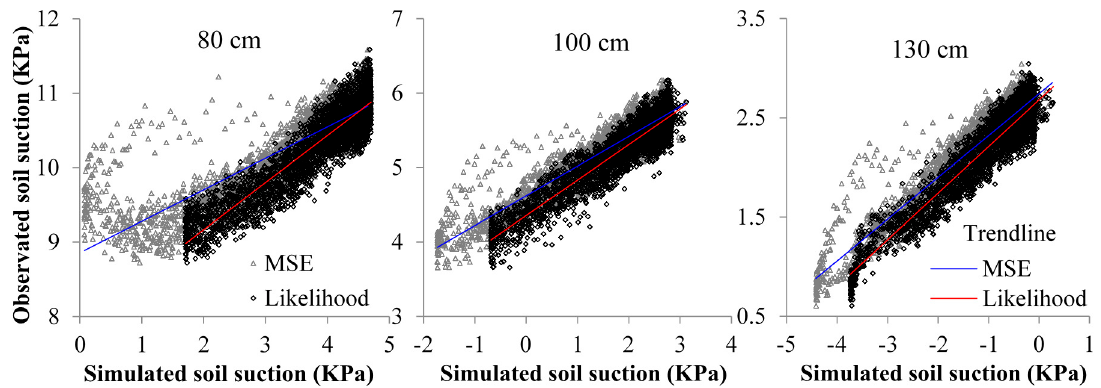
Figure 6. The observation soil suctions versus the simulations at the depths of 80, 100, and 130 cm in the first rainfall–runoff experiment. Note that the positive value of soil suction means that soil is unsaturated, rather than saturated, which is opposite to the value of the water pressure head.